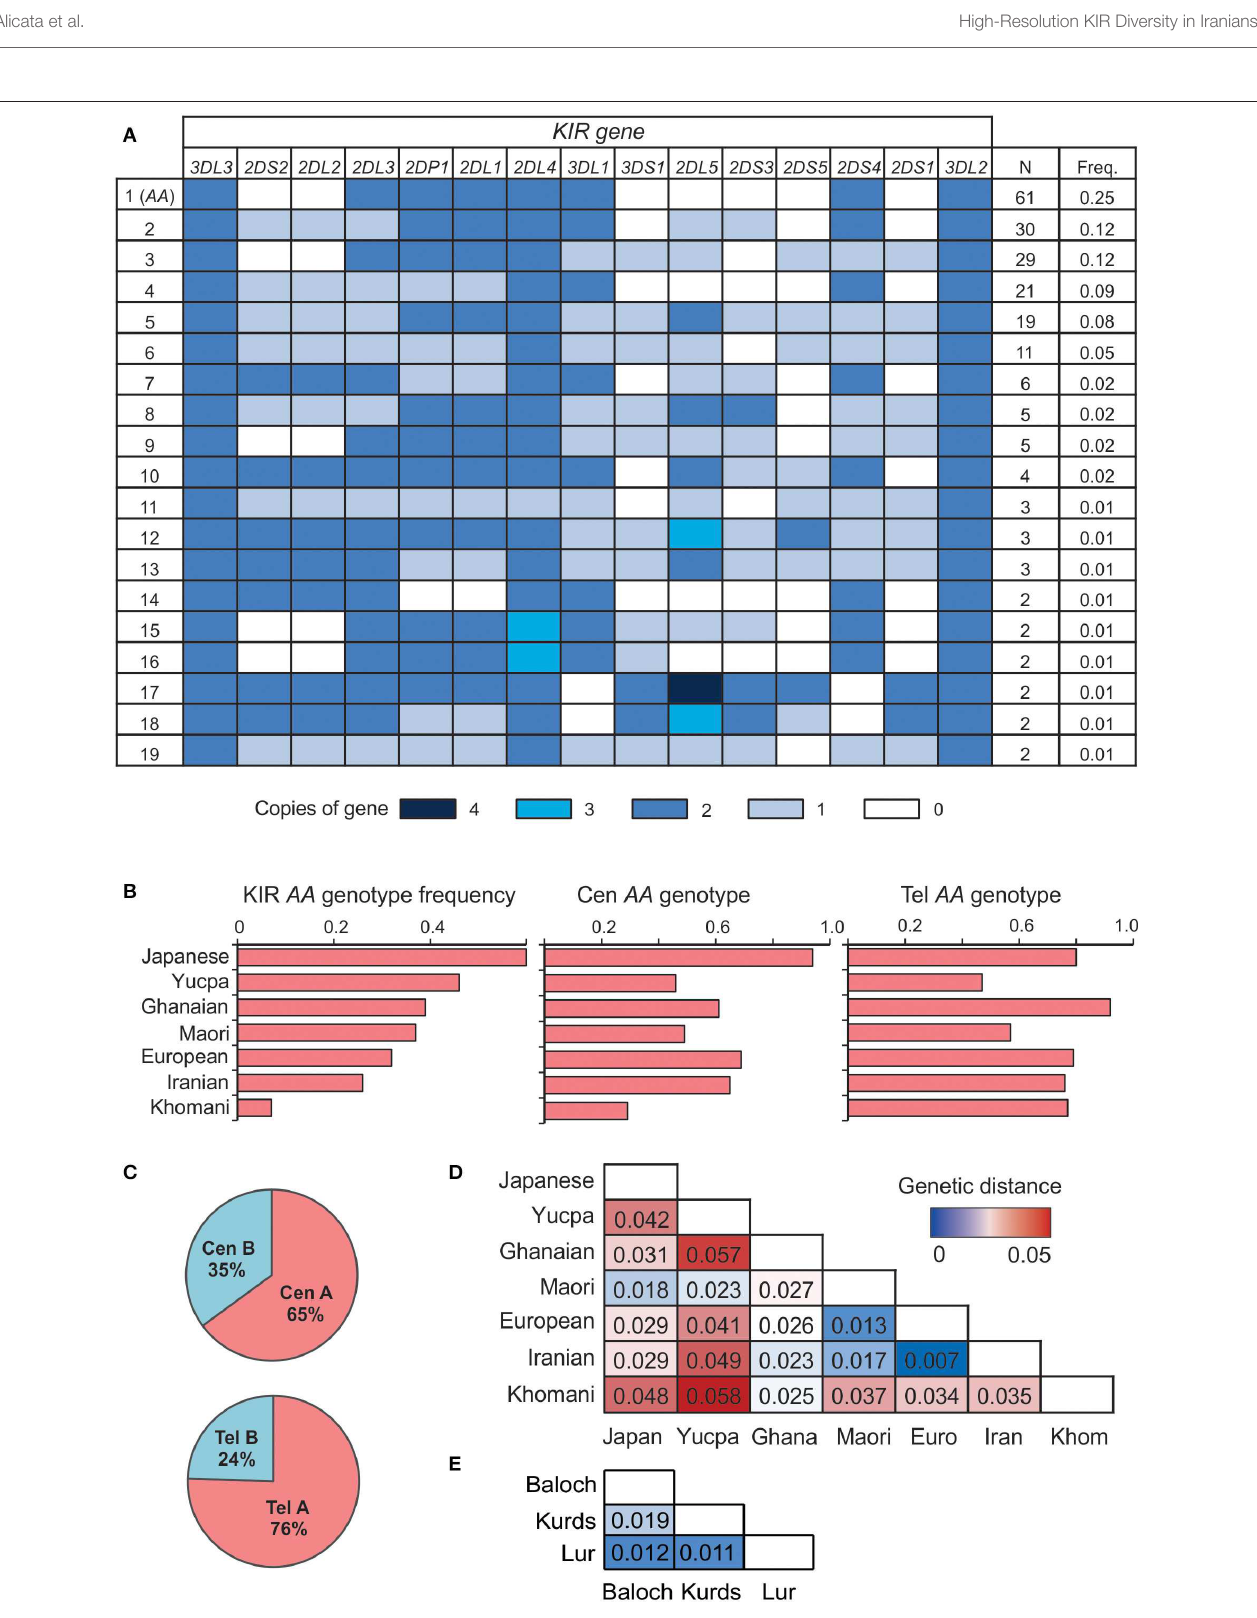
FIGURE 1 | Iranian KIR genotypes resemble those of Europeans. (A) Shows KIR gene copy-number genotypes ordered by the total number observed across the five Iranian populations. Only genotypes present in more than one individual are shown. Colored boxes indicate the number of copies of the gene, as given in the